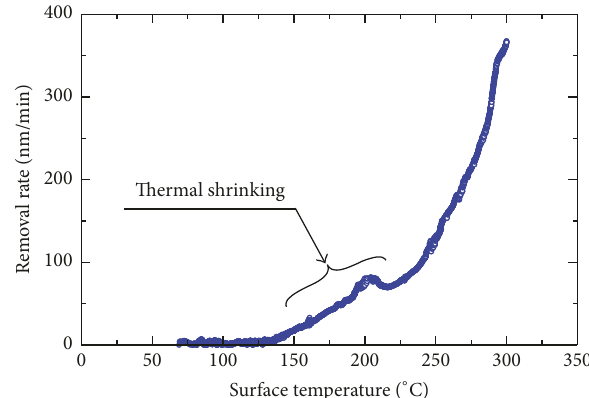
Figure 2: Removal rate calculated from the results of Figure 1 as a function of surface temperature.